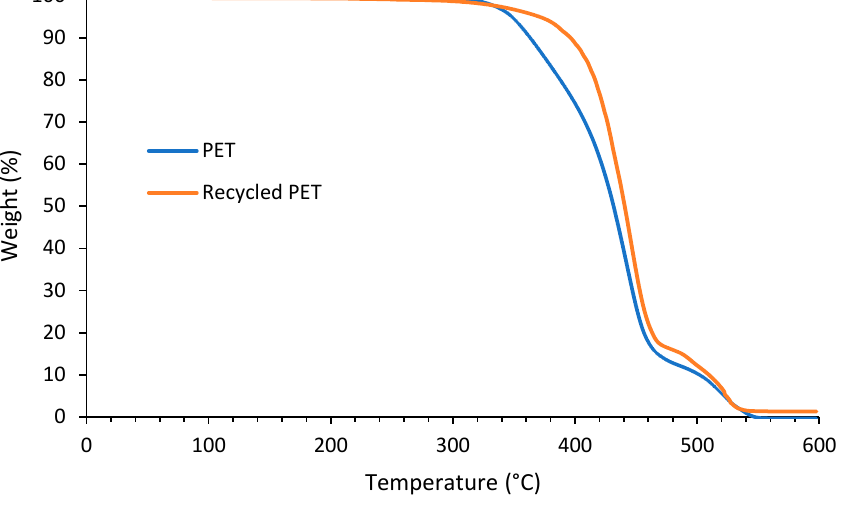
Figure 10. TGA curves of recycled PET and virgin PET.